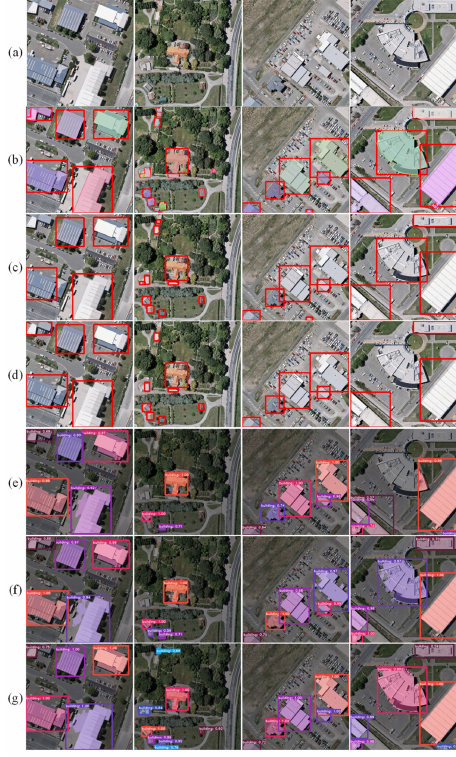
Figure 6. Results of building detection on the WHU dataset. ( a ) Images. ( b ) Labels. ( c ) YOLOv4.